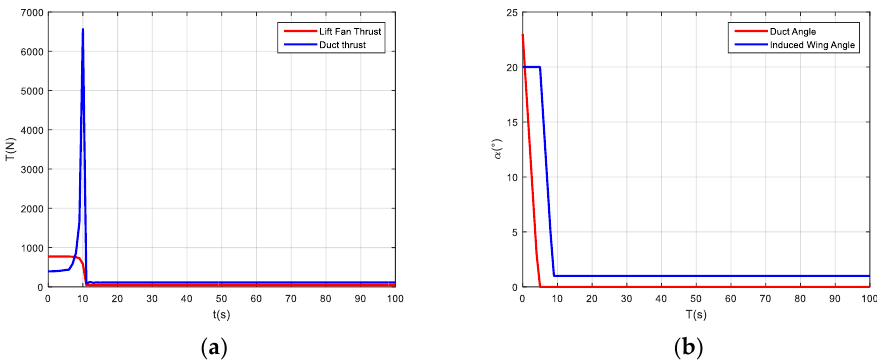
Figure 14. ( a ) Rapid transition of lift fan and lift duct thrust state when rapid deflecting duct and induced wing; ( b ) Rapid transition of forward speed and lift duct deflection when Rapid deflecting duct and induced